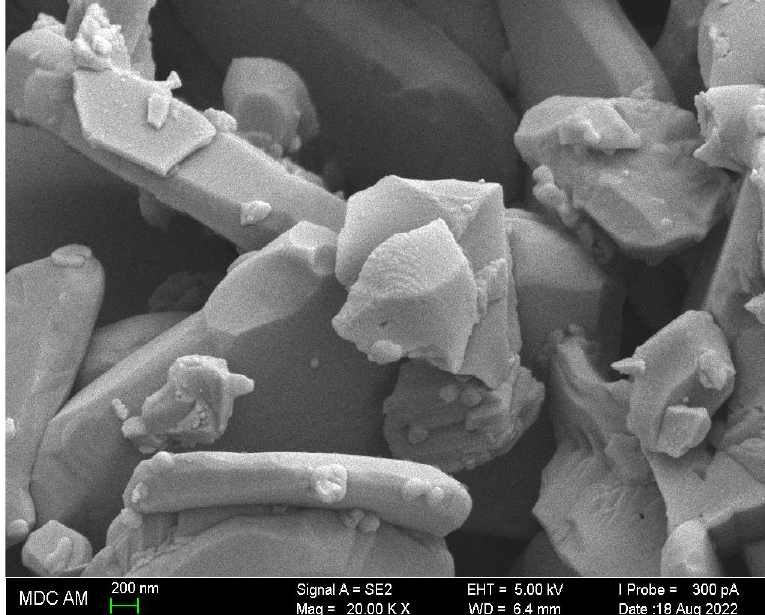
Figure 3. SEM image of the Na-Fe 3 O 4 catalyst particles.